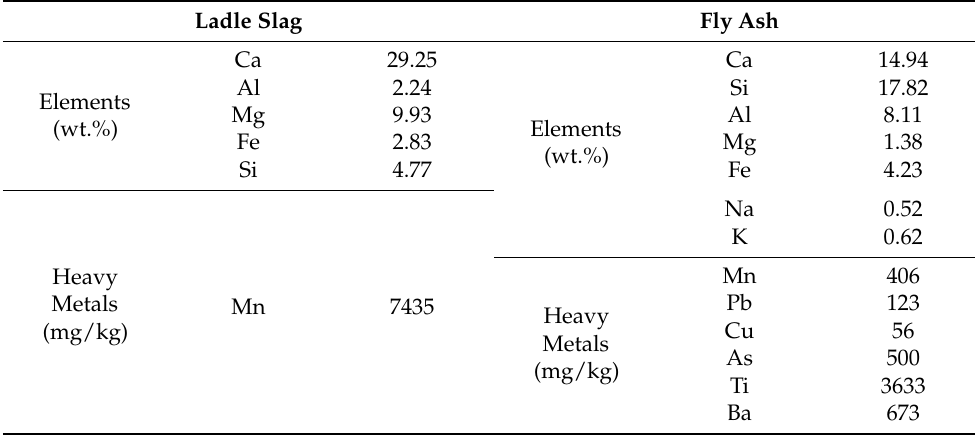
Table 1. Chemical compositions of ladle slag and fly